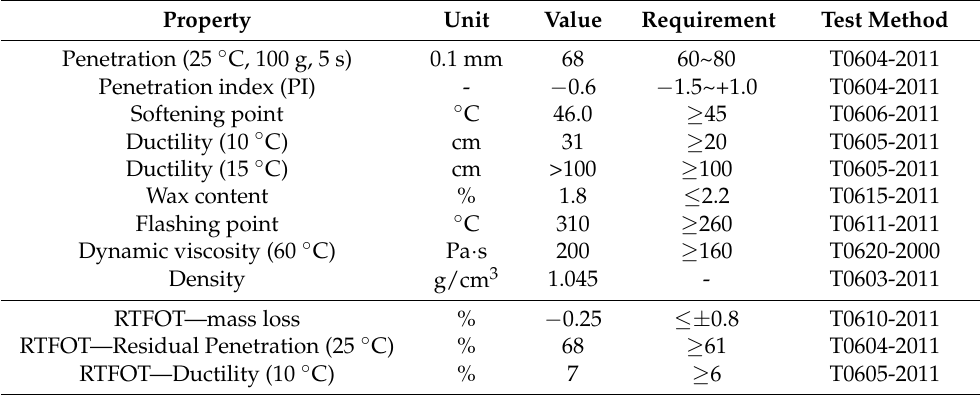
Table 1. Specifications of bitumen before and after short-term aging by rolling thin film ovens (RTFOT).